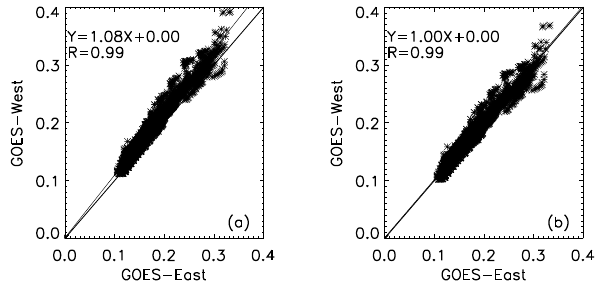
Fig. 13. (a) Scatter plot of GOES-West vs. GOES-East surface re- flectance retrievals with mirror symmetry applied at Boulder. (b) Same as the left figure, but the GOES-West TOA reflectance is mul- tiplied by a factor of 0.95.